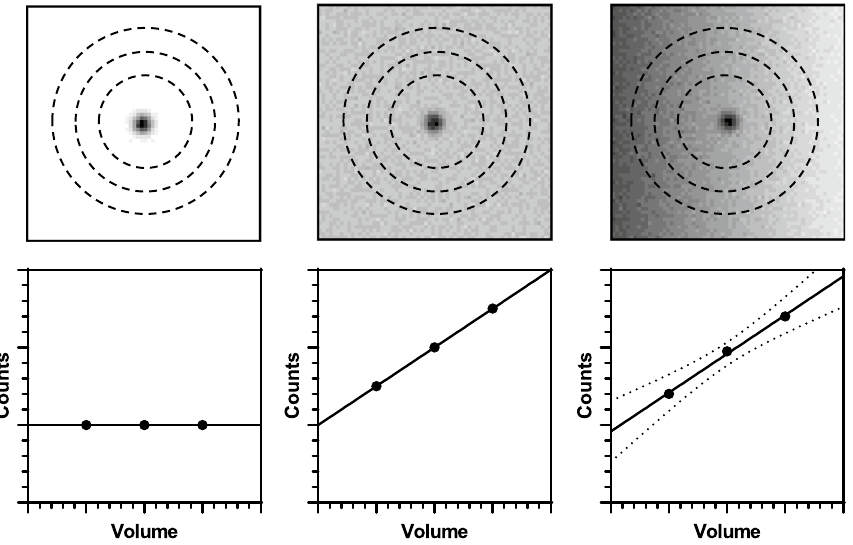
Fig. 1 Illustration of linear extrapolation to y‑intercept of cold, uniform, and anisotropic background using concentric oversized